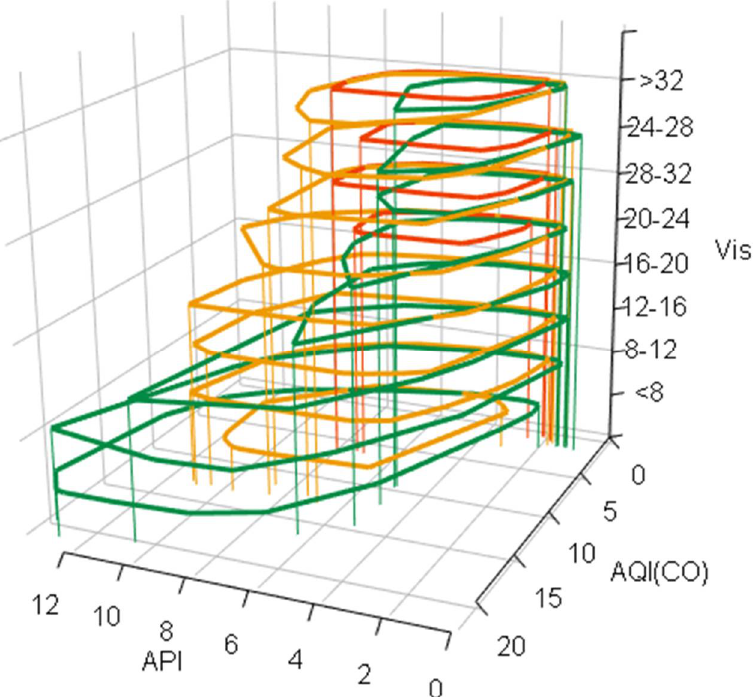
Figure A14. Effect of visibility-dependent CO air concentrations on the air pollution index for the spring, summer and winter rain-free periods.